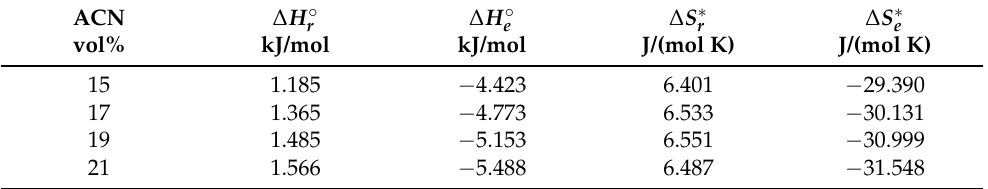
Table 2. Determined thermodynamic parameters as function of the acetonitrile content (ACN) of the mobile